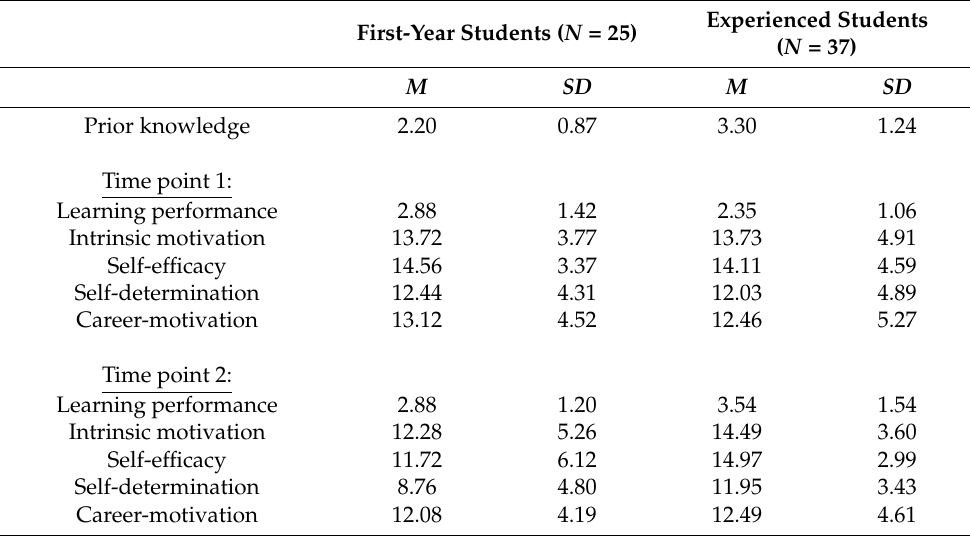
Table 1. Descriptive statistics of both groups for all measured